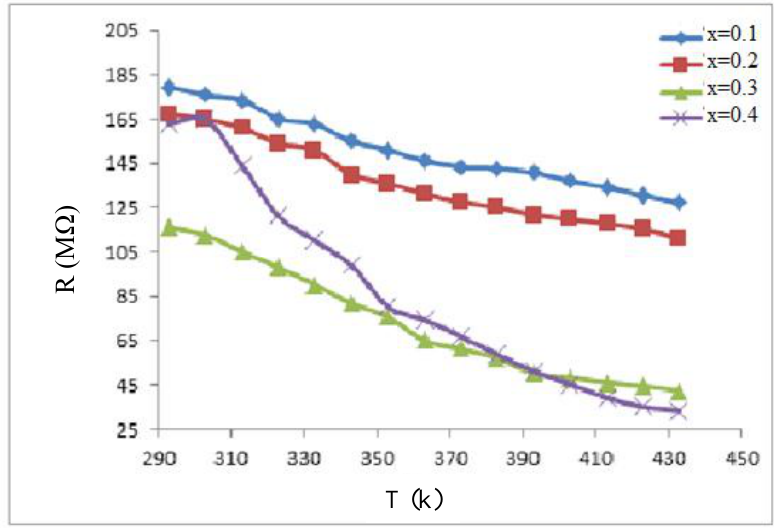
Fig. 6: The change of resistance with temperature for Mg 0.4.